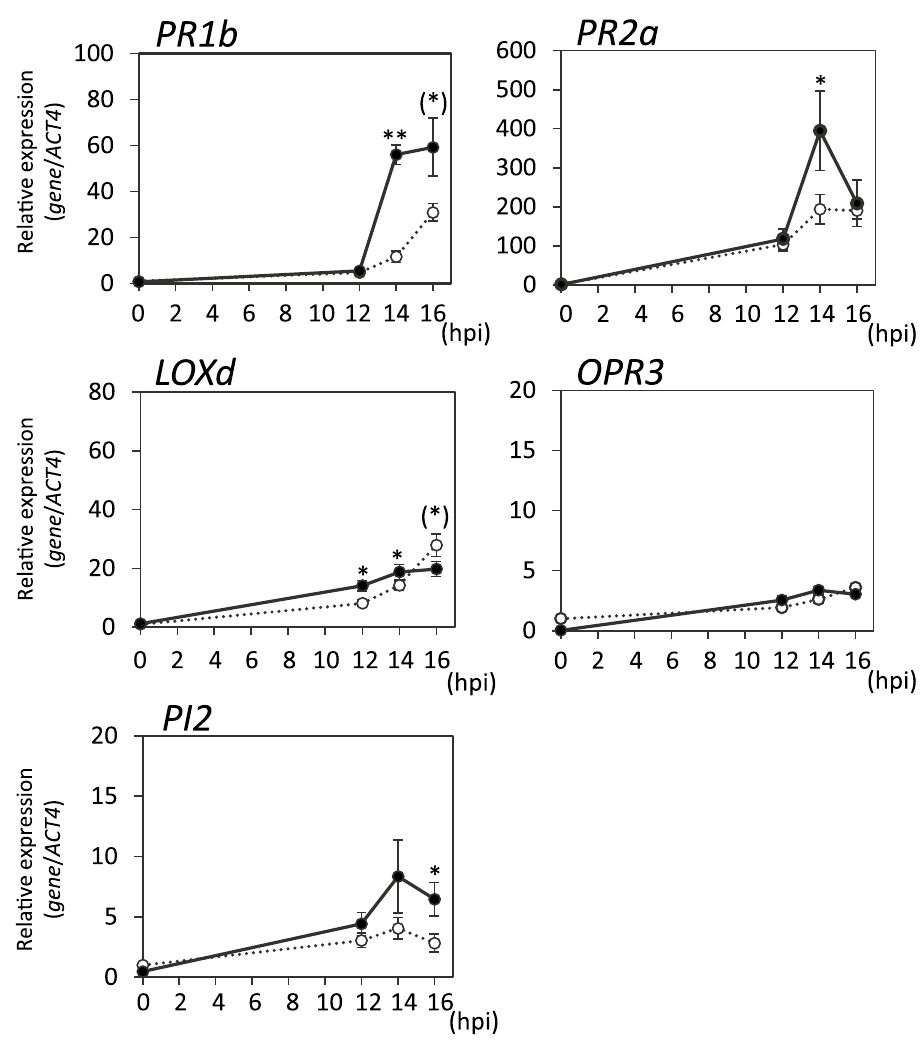
Figure 6. Expression of defense-related genes after infection with avirulent pathogen mutant Pso∆fliC. The G. margarita -colonized (14 days after G. margarita inoculation) and the water-treaterd control tomato plants were inoculated with Pso∆fliC . Leaf disks were taken from the Pso∆fliC -infiltrated part of the leaflets at the indicated time points (0, 12, 14, 16 h post inoculation (hpi)) and used for gene expression analyses of SA-related genes ( PR1b and PR2a ) and JA-related genes ( LOXd, OPR3 and PI2 ). Transcript levels were normalized to the expression of ACT4 measured in the same samples. The means and SEs were calculated from 4 independent samples, each prepared from a single plant. Open circle, water-treated control plant; closed circle, G. margarita - colonized plants. Asterisks indicate statistically significant difference between data of the water-treated control and G. margarita -colonized plants (two-sided t-test; **, p < 0.01; *, p < 0.05; (*) in PR1b , p = 0.056; (*) in Loxd , p = 0.051). The experiment was repeated three times with similar